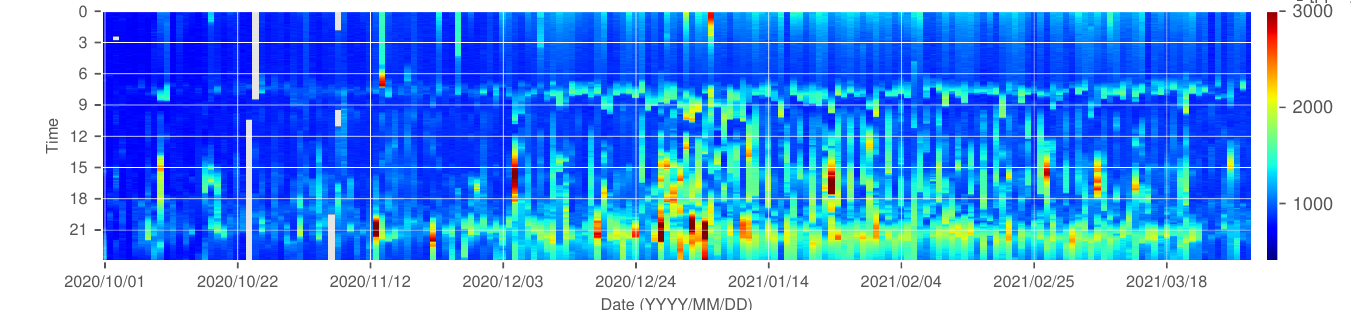
Figure 7. The heatmap of CO 2 concentration at ID 14.